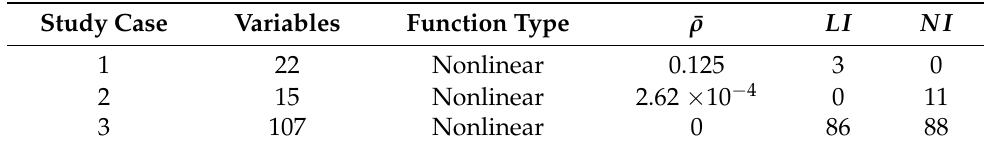
Table 5. Summary of the main attributes of the mechanism synthesis optimization problems applied to lower limb